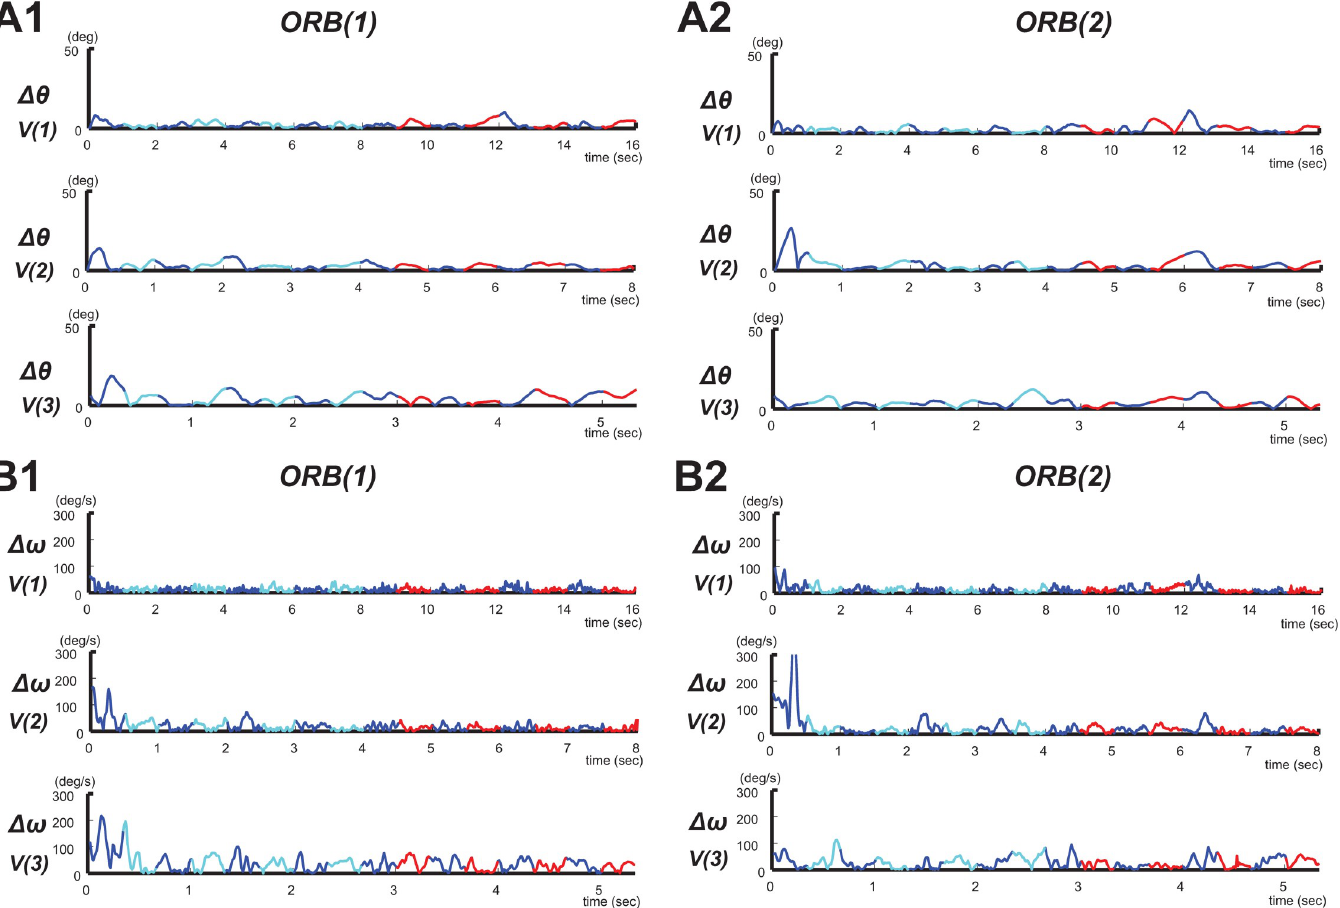
Fig 2. Typical examples of circular tracking movements at speeds of 0.25, 0.5, and 0.75 Hz. V(1) : 0.25 Hz (n = 19), V(2) : 0.5 Hz (n = 19), and V(3) : 0.75 Hz (n = 19). ( A1 ) Absolute values of Δ θ under ORB(1) and ( A2 ) under ORB(2) . ( B1 ) Absolute values of Δ ω under ORB(1) and ( A2 ) under ORB(2) . In the graphs, the regions of VIS(1) and VIS(2) are indicated in cyan and red,